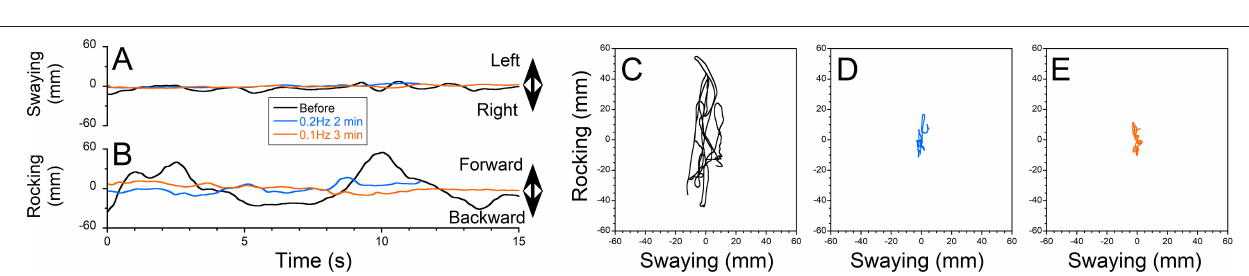
decreased to a score of 2. The patient never came back for more treatments ( Figure 1C , blue